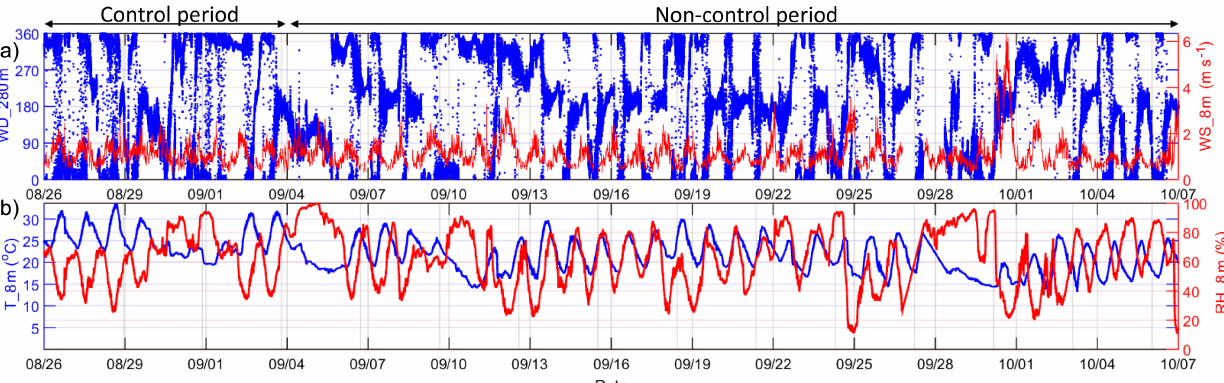
Figure 2. Time series of (a) wind direction at 280m (in blue) and wind speed at 8m (in red) and (b) ambient temperature at 8m (in blue) and relative humidity at 8m (in red) during the control and non-control periods at the Beijing site (26 August–6 October 2015).